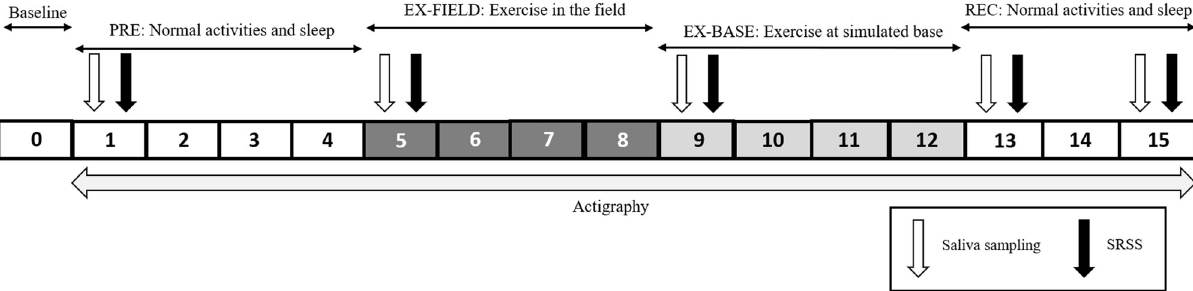
Fig 1. Outline of the 16-day data collection period, comprising four distinct periods. SRSS: Short recovery stress scale.